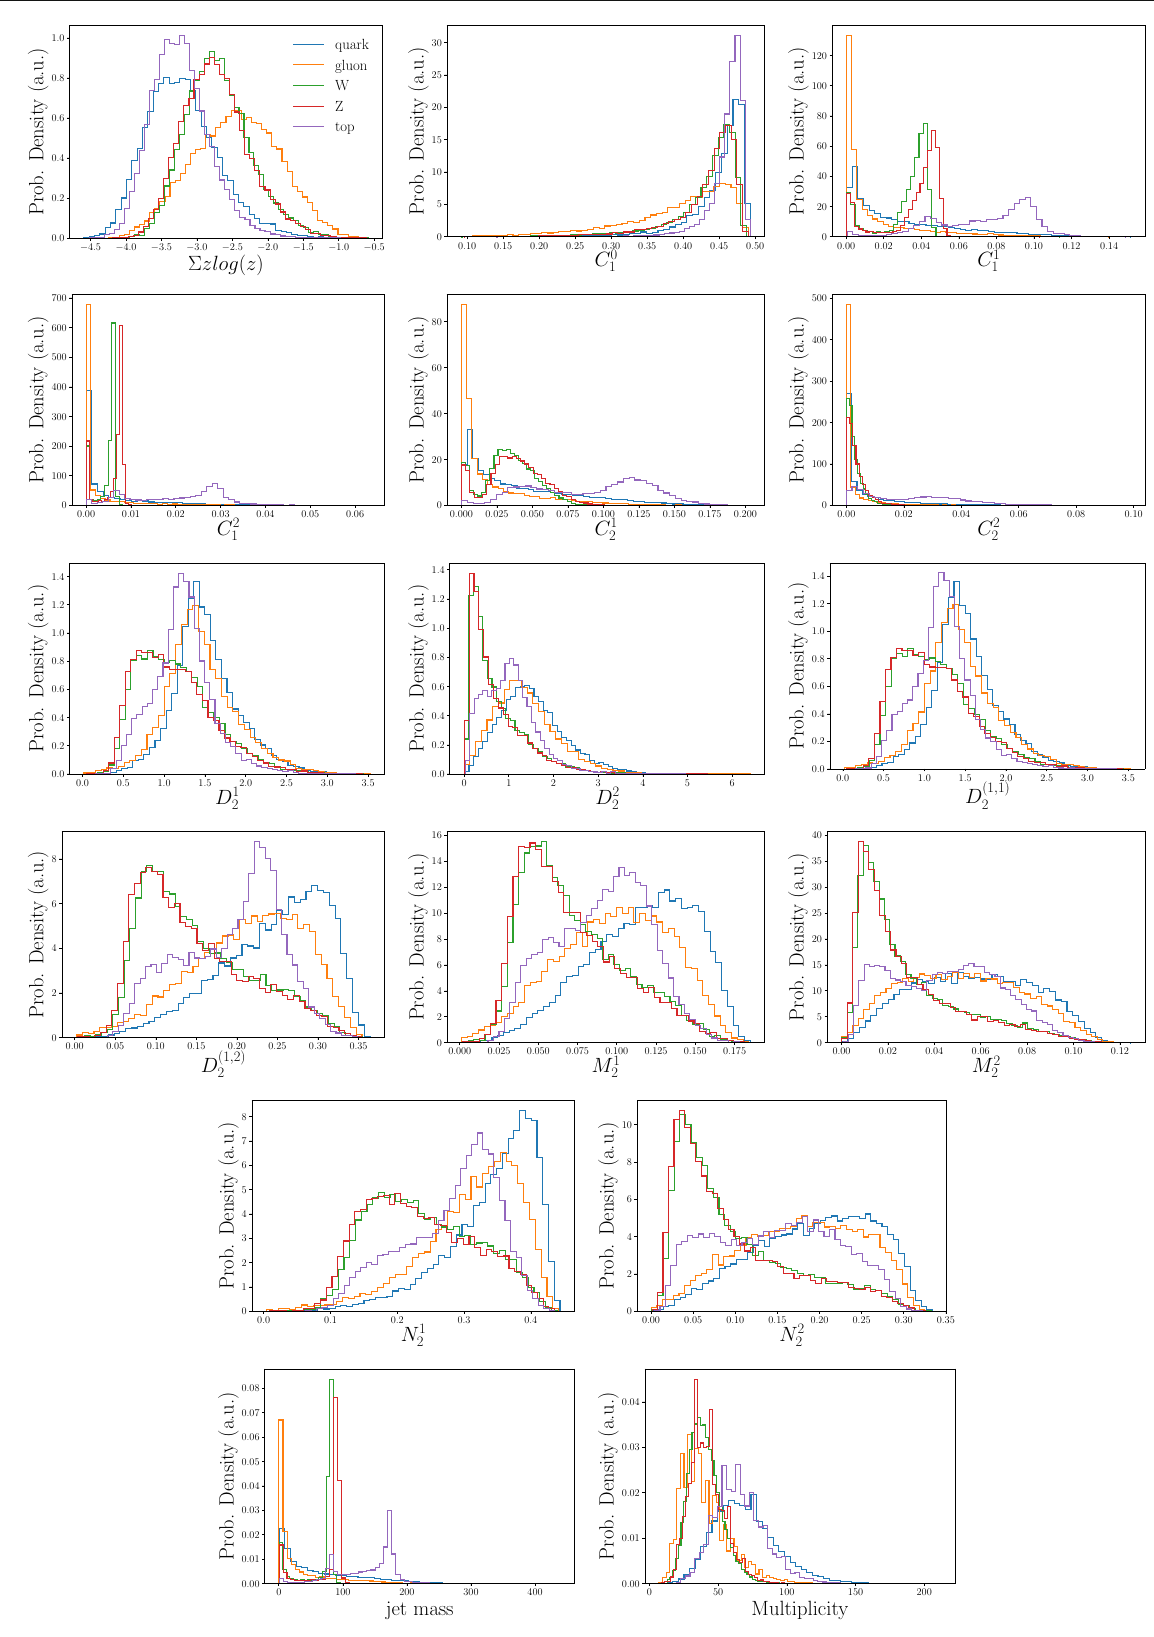
Fig. 2 Distributions of the 16 high-level features used in this study, described in Ref.